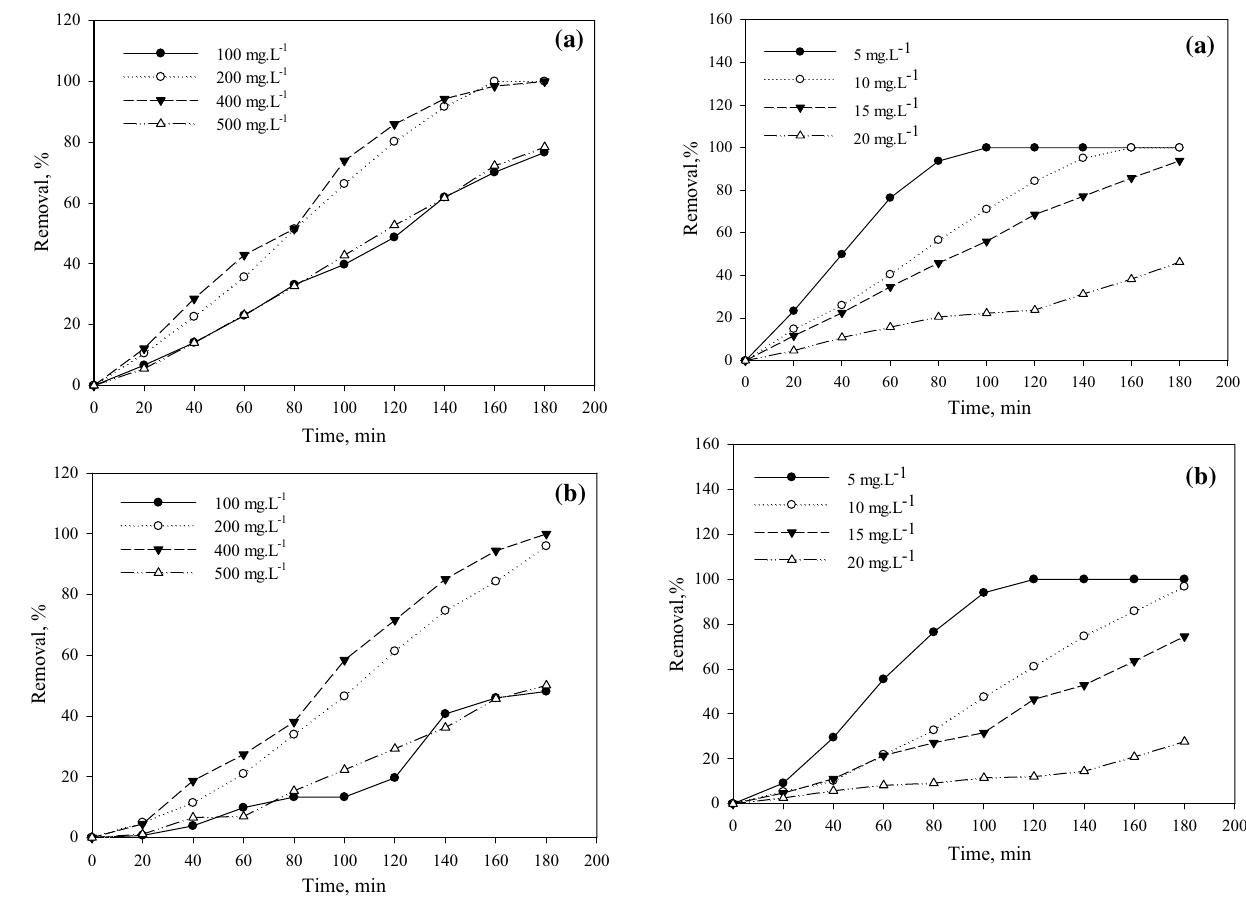
Fig. 8 Effect of catalyst amount on the rate bleaching ( a ) and dye degradation ( b ) of MO. Methyl orange of 10 mg L −1 , pH 6 and time